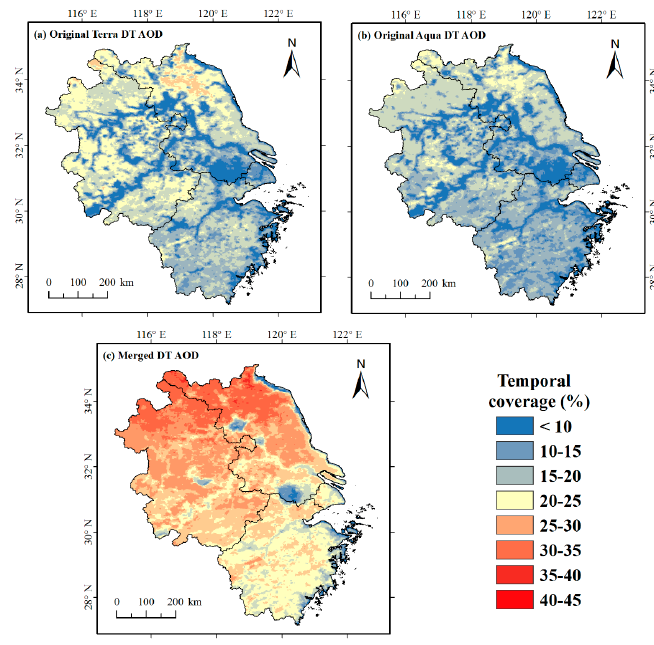
Figure 5. The spatial distribution of temporal coverage (pixel-level) of (a) original Terra DT AOD, (b) original Aqua DT AOD, and (c) merged AOD. The temporal coverage of the merged AOD data varied from area to area (Figure 5c). While more days were available in north Jiangsu and north Anhui with the percentage of availability mostly from 25% to 40%, fewer days were available in Shanghai and the most of Zhejiang with the percentage of availability mostly ranged from 20% to 25%.